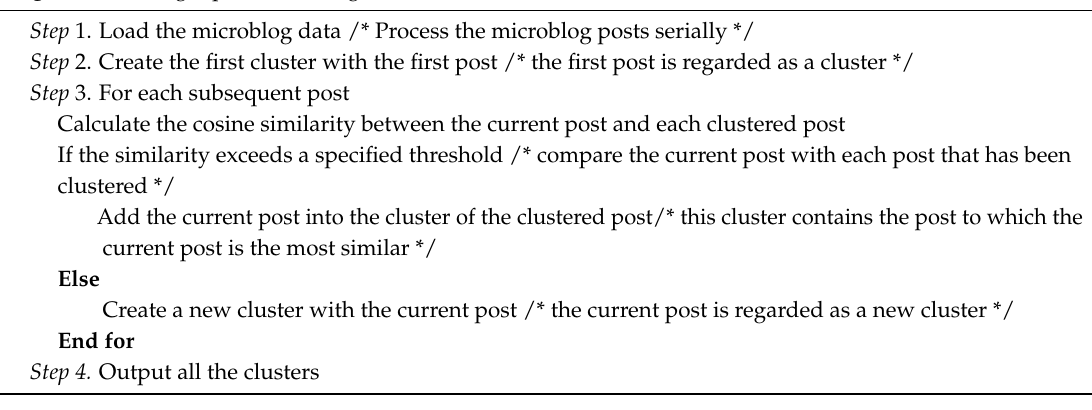
Algorithm 1 : Single-pass clustering based on 1NN